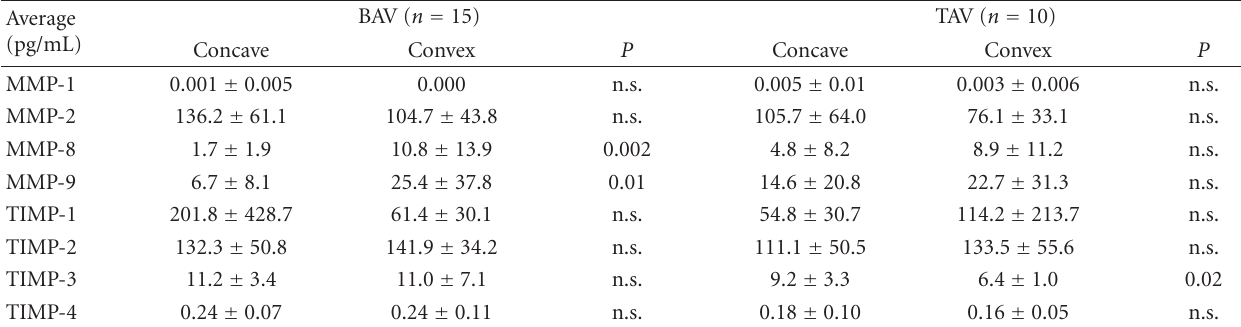
Table 4: Age di ff erences and detection of MMPs and TIMPs in BAV and TAV patients aged ≥ 52 years.